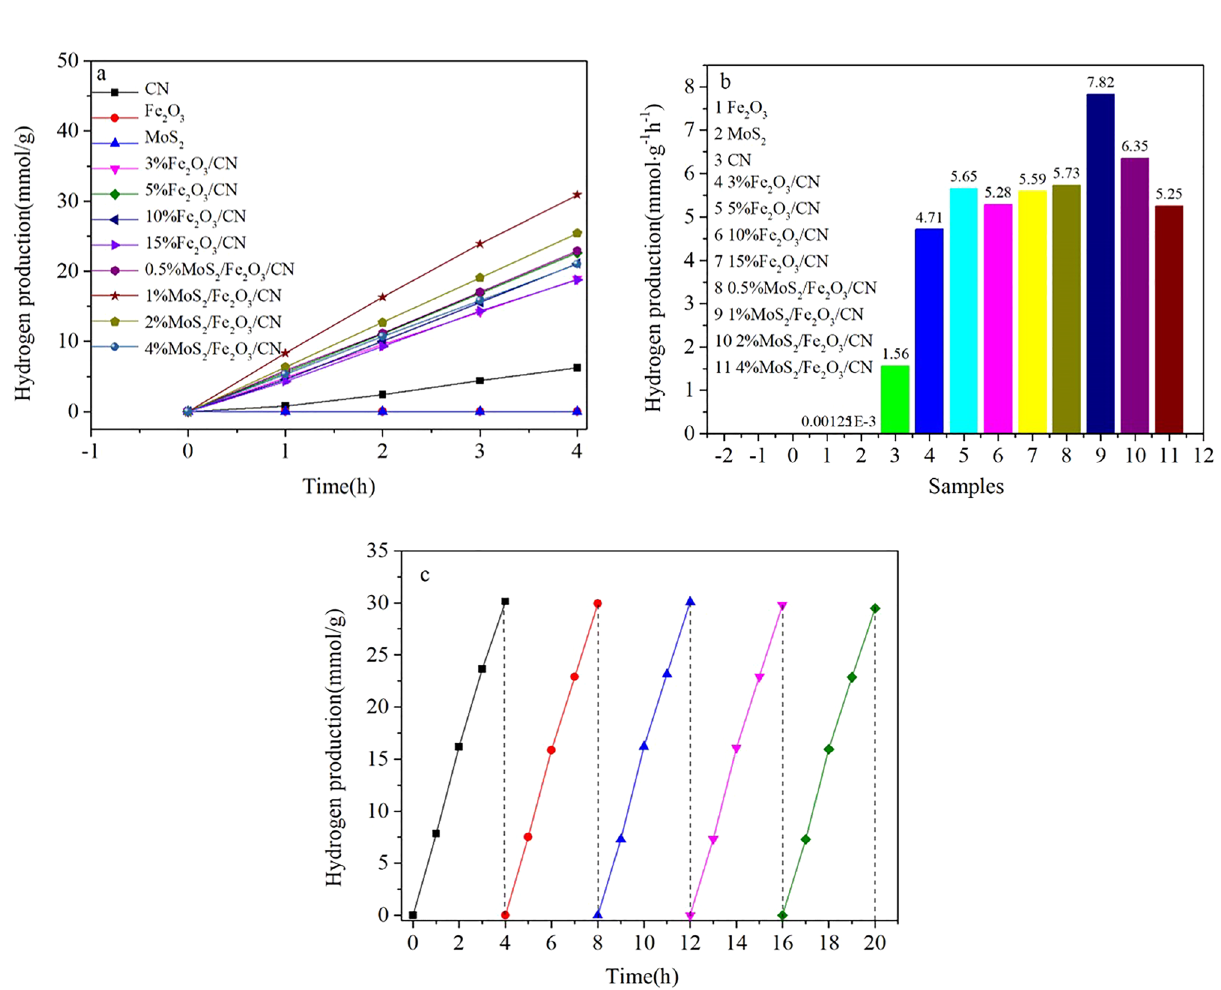
Figure 9. ( a ) The Hydrogen accumulation of different samples, ( b ) the Hydrogen producton rate of different samples, ( c ) the hydrogen production cycle of 1%MoS 2 /Fe 2 O 3 /CN composite